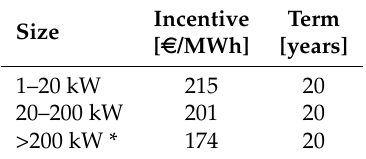
Table 5. Standard tariffs for concentrating PV plants established in [63].